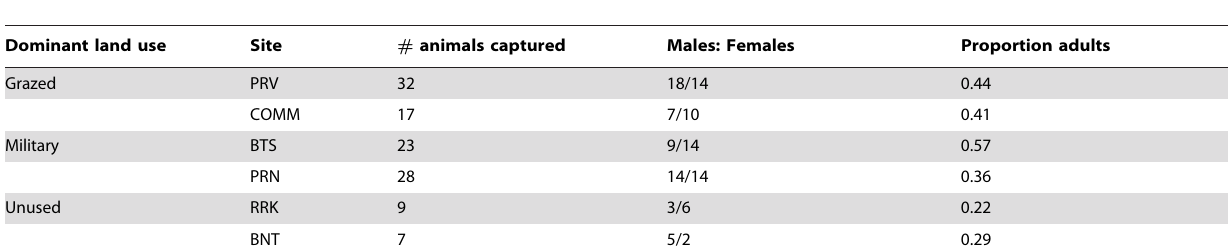
Table 1. Number, age, and sex ratios of swift foxes captured in 6 sites in southeastern Colorado, USA, 2001–2004.